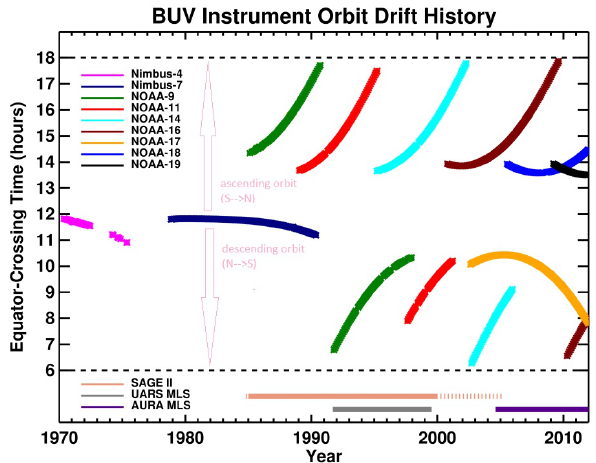
Fig. 1. Equator crossing times of the SBUV instrument series as a function of time. The SBUV data set includes measurements ob- tained from the Nimbus-4 BUV instrument, the Nimbus-7 SBUV instrument, and the series of SBUV/2 instruments on board NOAA satellites 9, 11, 14, 16, 17, 18, and 19. The orbital properties of each satellite vary. In general, measurements taken within the 08:00– 16:00 ECT range are less noisy. Periods of operation for SAGE II, UARS MLS and Aura MLS are denoted at the bottom of the